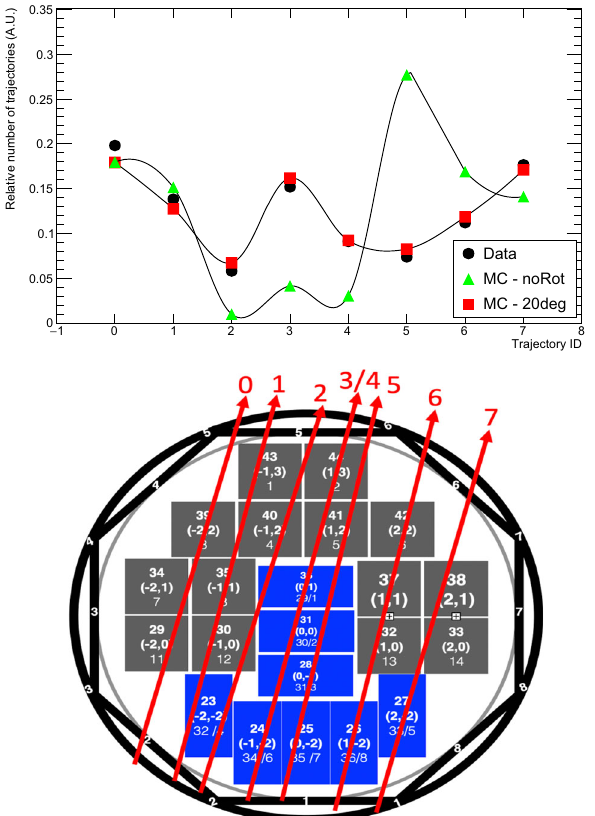
Fig. 14 Top:relativenumberofmuontrajectoriesasafunctionoftheir ID number for the Bottom half of the ECal. Data are compared with MC predictions for the detector in the nominal position (noRot) and rotated clockwise by 20 ◦ . Similar results have been found for the Top half. Bottom: arrows schematically indicate the set of muon trajectories (numberedfrom0to7)usedtocalibratethecrystals.Crystalnumbering refers to the Bottom half of the ECal